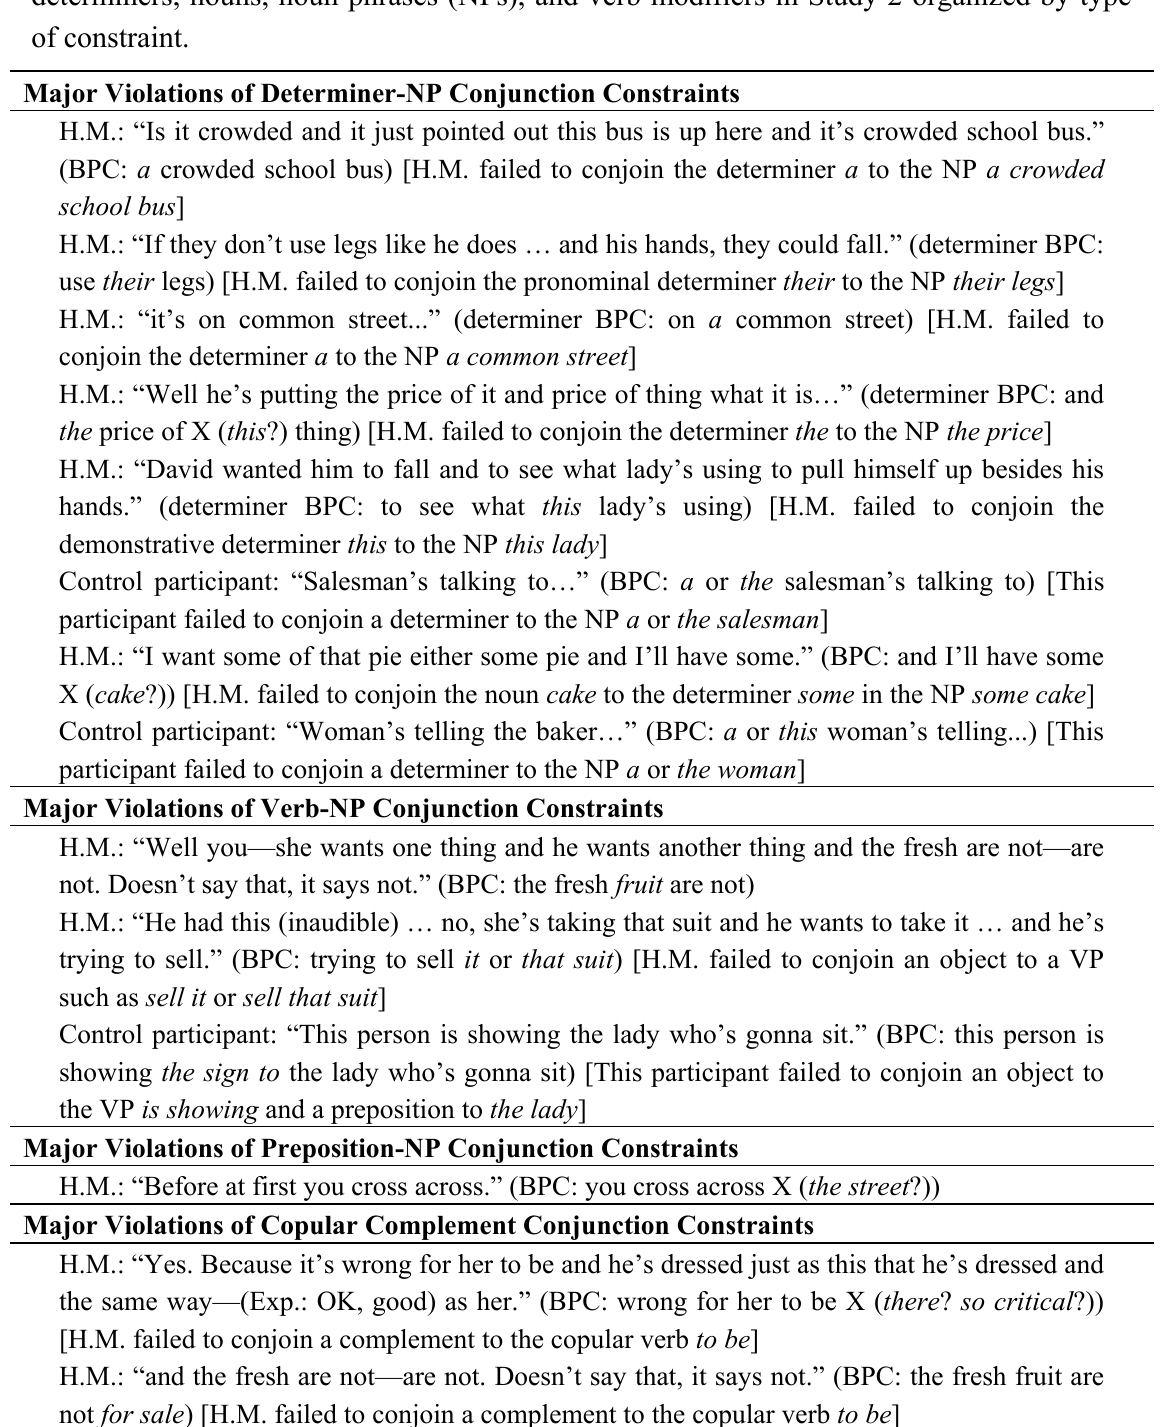
Table 4. Major omission-type violations of conjunction constraints (CCs) involving determiners, nouns, noun phrases (NPs), and verb modifiers in Study 2 organized by type of